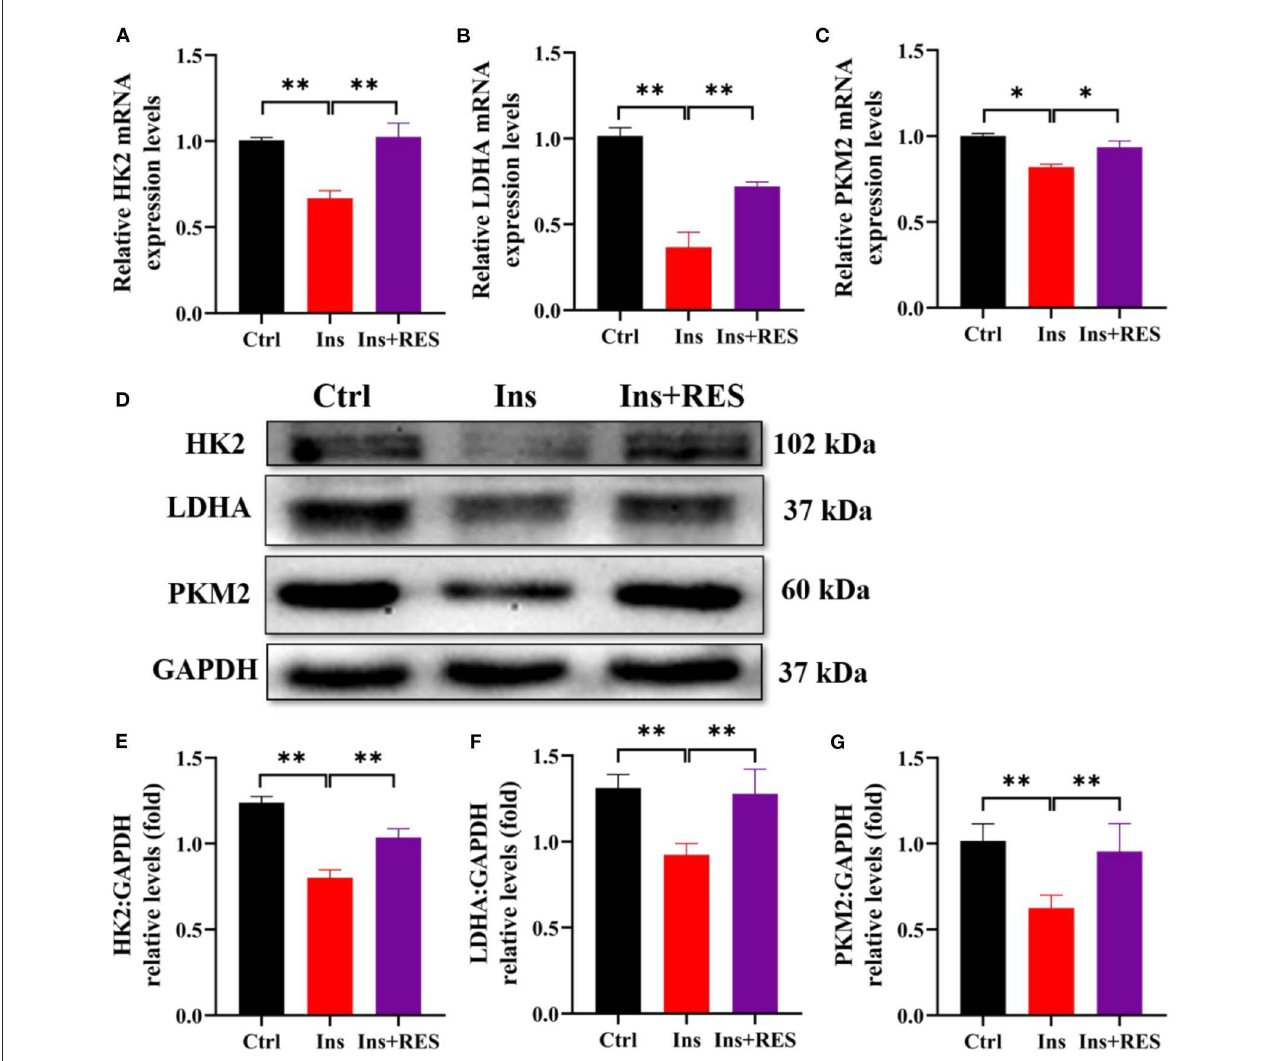
FIGURE3 RES can improve the expression of key glycolytic enzymes of insulin-treated KGN cells. The relative mRNA expression levels of HK2 (A) , LDHA (B) , and PKM2 (C) in KGN cells were determined using qPCR. The protein levels of HK2, LDHA, and PKM2 were determined by Western blot (D) and quantified by ImageJ software (E–G) . Significant differences between the groups are shown as * P < 0.05 and ** P <